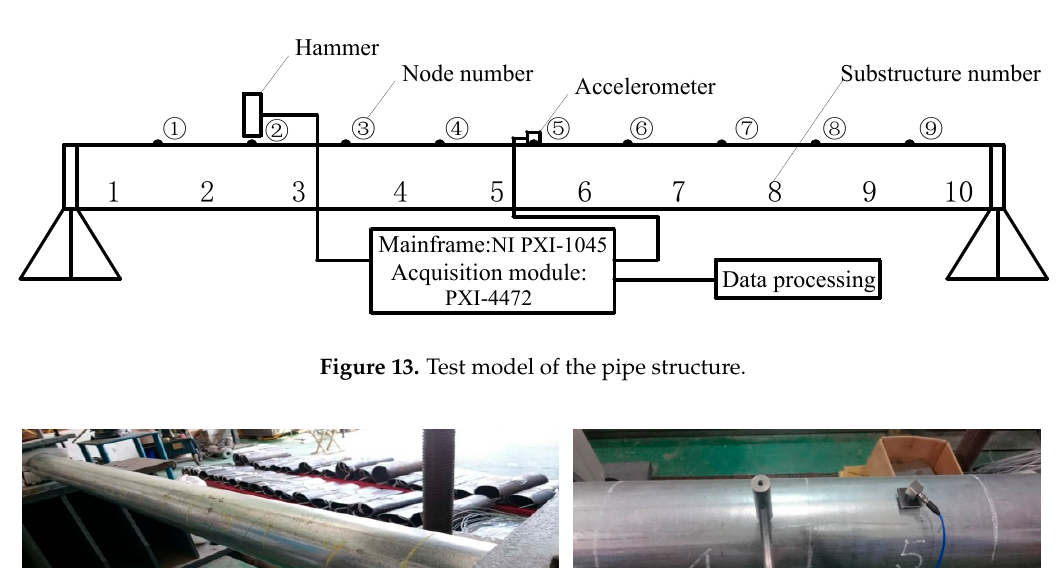
11 of 15 Figure 12. Case 2: identified extents of damage. 4. Test of the Pipeline Damage Identification